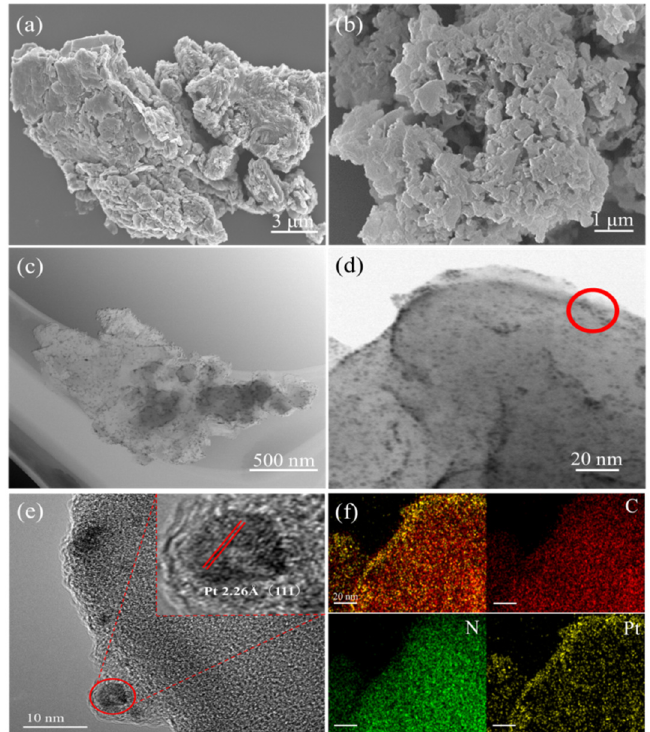
Figure 2 . The morphology and atomic structure of Pt/CN. ( a ) block CN, ( b ) nanosheet CN, ( c − e ) TEM image, ( f ) EDX mapping of